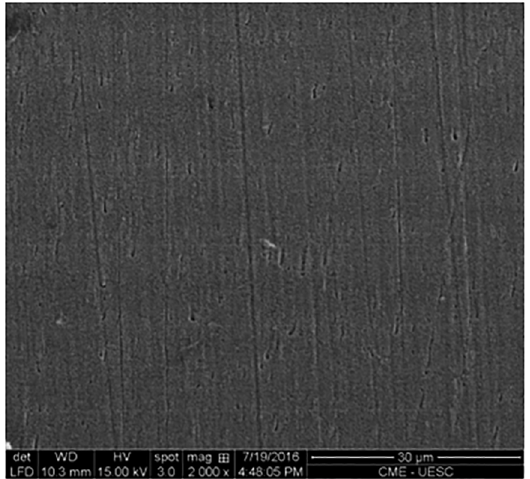
Figure 11. SEM micrograph of AISI 1020 carbon steel after 12 h of immersion in HCl 0.5 mol.L -1 in the presence of 1.77 g.L -1 of castor bark